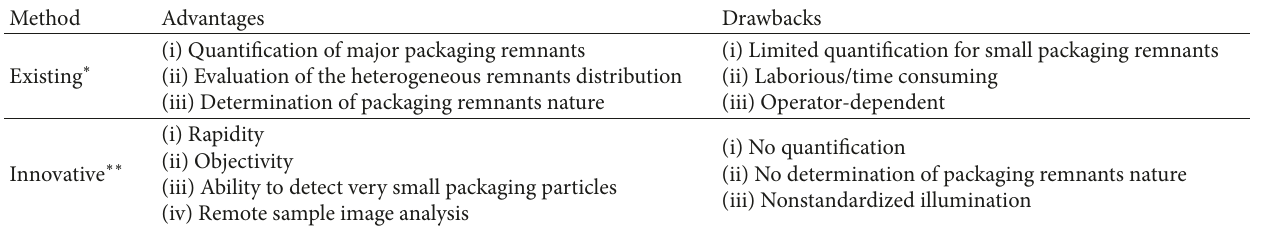
Table 2: Advantages and drawbacks of existing and innovative methods.